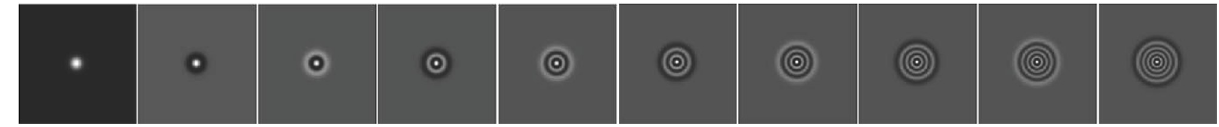
Fig 3. Exampled 10 number of LG spatial channel images with a u = 11 pixels (left: p = 0, right: p = 9).